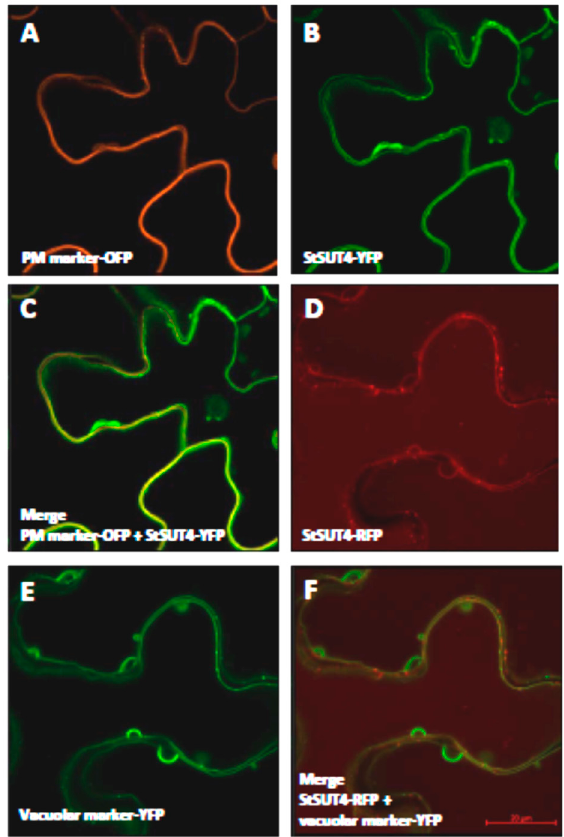
Figure 6. Colocalization of StSUT4 with di ff erent marker proteins. ( A ). Plasma membrane marker protein CBL1-OFP. ( B ). StSUT4-YFP alone. ( C ). Overlay picture of StSUT4-YFP and the PM marker